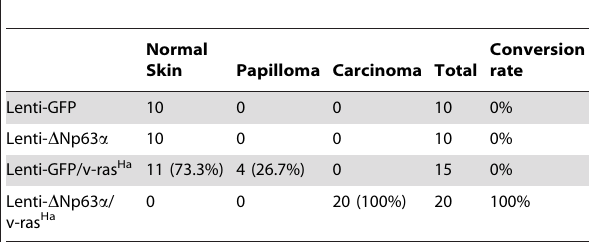
Table 1. Elevated D Np63 a levels enhance malignant conversion in v-ras Ha -expressing